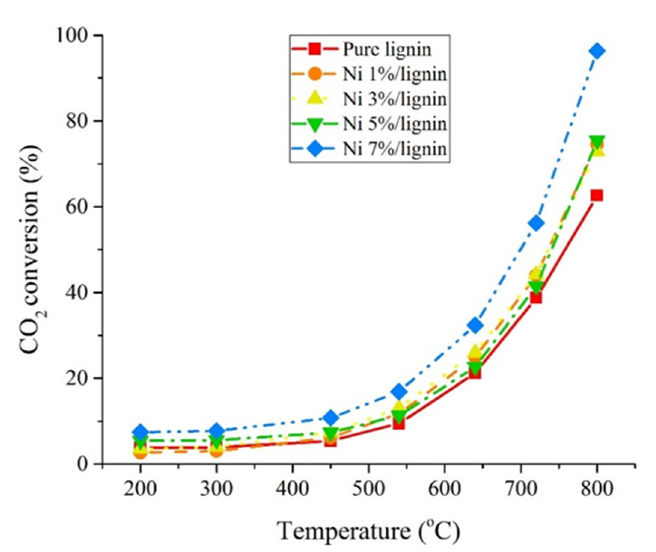
Figure 1. Dependence of the carbon dioxide conversion on temperature in the process of carbon dioxide assisted conversion for samples of the initial hydrolysis lignin and samples of hydrolysis lignin with deposited nickel compounds: 1%, 3%, 5%, and 7% by weight.